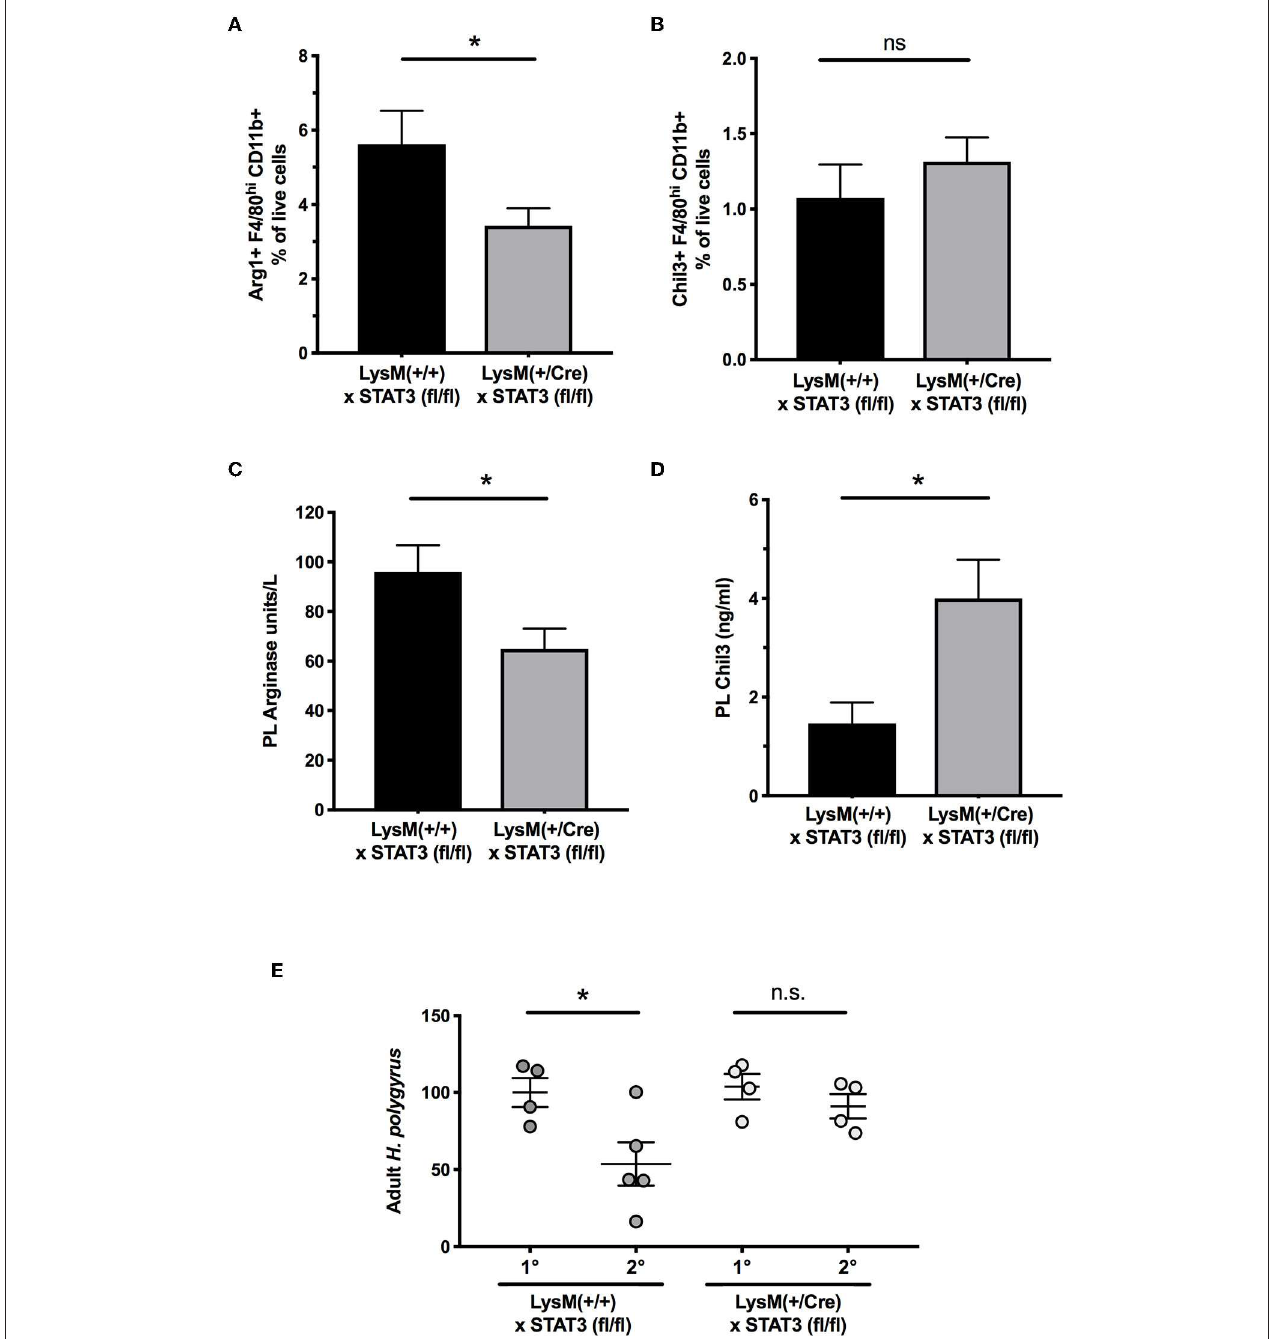
FIGURE 8 | Myeloid cell expression of STAT3 is required for optimal Arginase-1 expression and for secondary immunity to H polygyrus. (A) Peritoneal macrophages were recovered from control and conditional STAT3 gene deleted mice, with genotypes of STAT3 fl / fl xLysM-Cre − / − and STAT3 fl / fl xLysM-Cre + / − , respectively, and stained for surface CD11b and F4/80, together with intracellular Arginase-1. Staining was evaluated by flow cytometry. Data are pooled from three independent experiments. (B) Expression of Chil3 within the same macrophage populations. Data are pooled from three independent experiments. (C) Peritoneal lavage fluids were recovered from the same animals as in (A,B) , and functional soluble arginase levels measured by an enzyme assay * p < 0.05. (D) Presence of Chil3 protein in the same lavage fluids as (C) * p < 0.05. (E) Myeloid cell-specific deletion of STAT3 impairs secondary immunity. LysM Cre xSTAT3 fl / fl mice and STAT3 fl / fl controls) were infected with H. polygyrus and infections cleared with pyrantel embonate. Mice were subsequently challenged with a secondary infection, or infected for the first time for primary controls, and adult worms counted in the small intestine at d21 post infection. Results are combined from two experiments with similar results. n.s., not significant, * p <